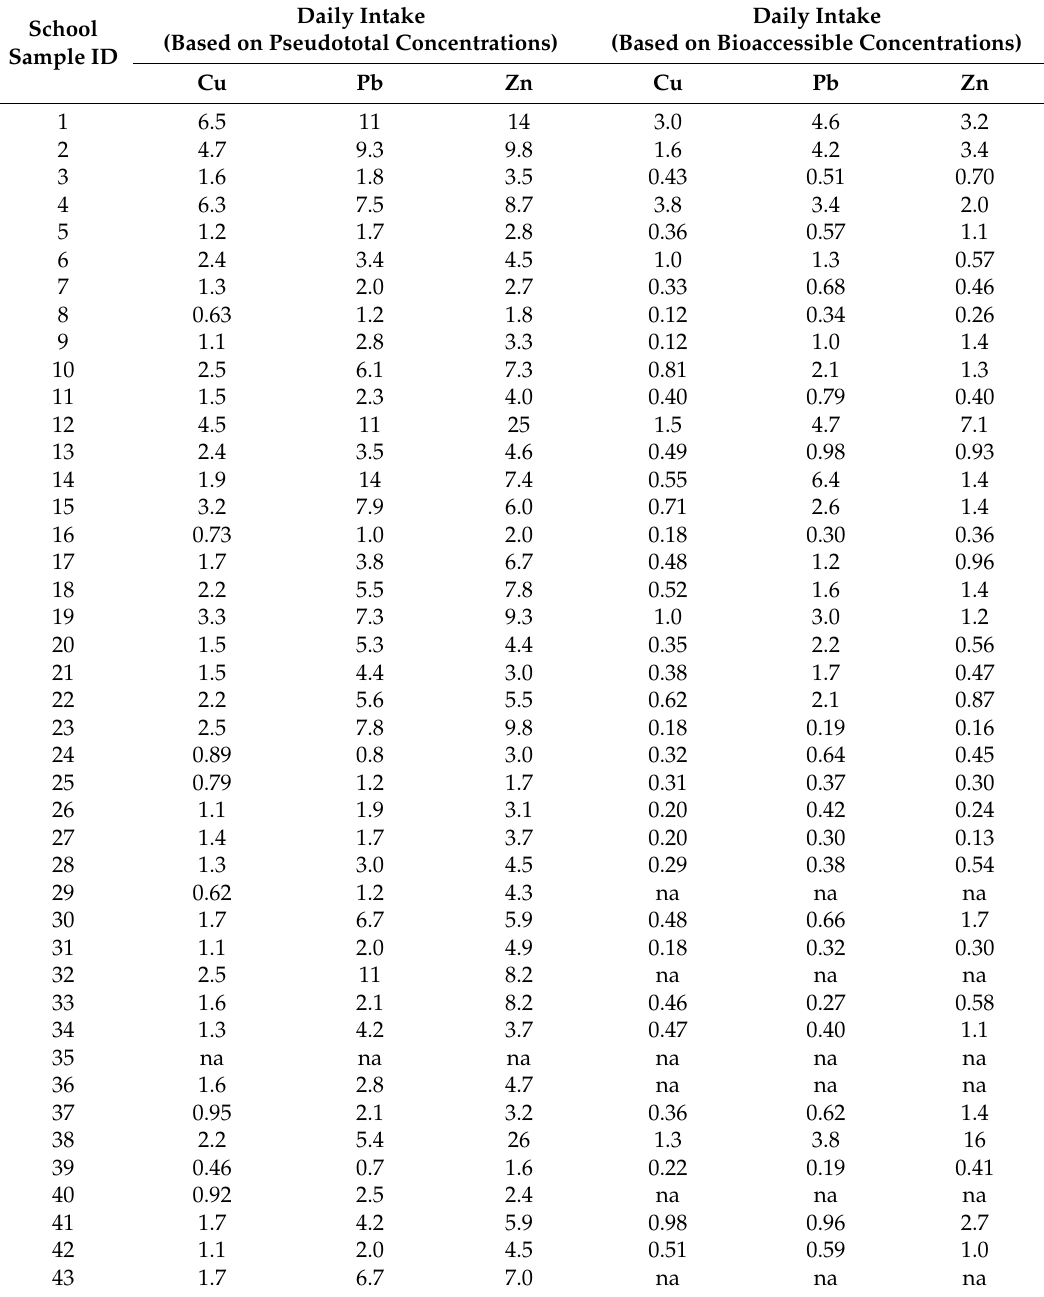
Table 4. Estimated daily intake of copper, lead and zinc from ingestion of soil (ng · kg − 1 BW